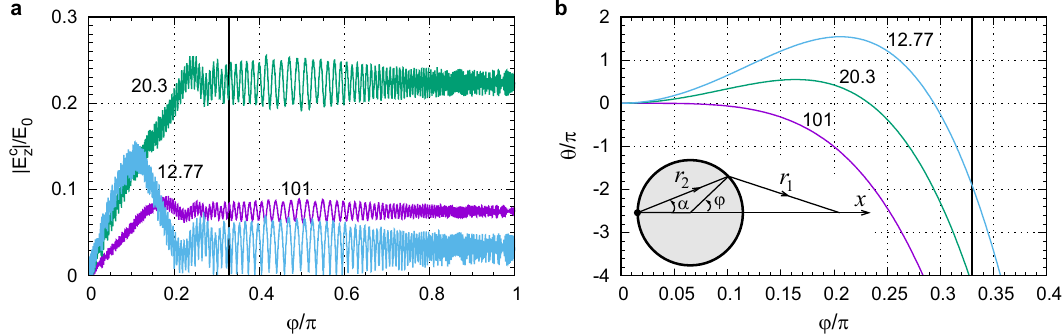
( x , ϕ) 100 at several observation points: x / R 101 (focus E c Figure 7. ( a ) Cumulative field for R / (cid:31) z = = | | 20.3 (diffraction focus defined by the furthest PSF maximum), x / R 12.77 according to paraxial GO), x / R = = (PSF minimum). ( b ) Phase difference θ(ϕ) , see Eq. (7), between the ray initially propagating at α (and crossing 2.02 . 2 α ) and the axial ray for the same observations points as in ( a ). For both frames n r the surface at ϕ = = 2arcsin ( 1 / 2.02 ) 0.33 π The vertical solid lines in ( a ) and ( b ) define the TIR angle ϕ = ≈